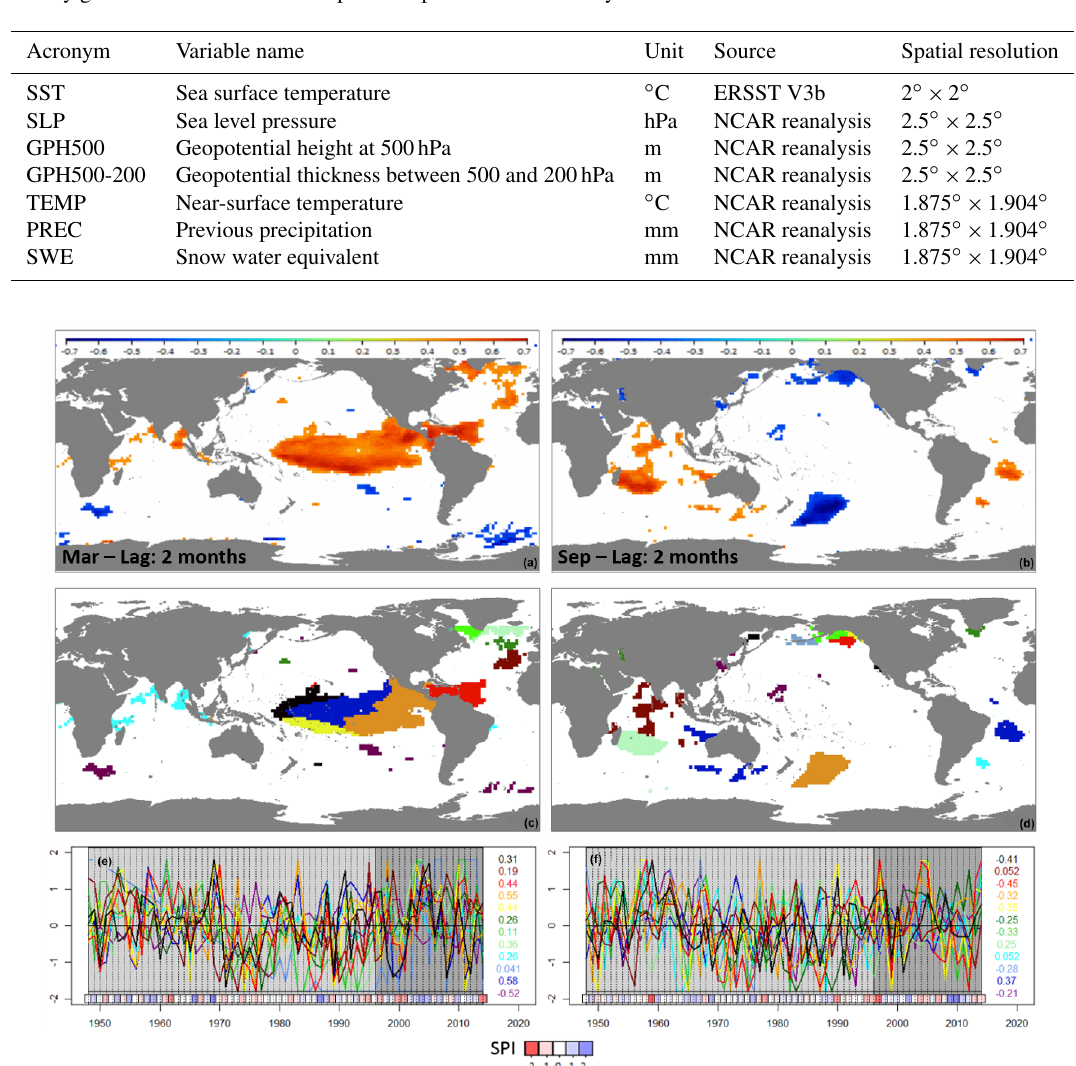
Figure 2. Correlation analysis results for precipitation anomalies of northern central Asia for March and September with a lead time of 2 months (a) and (b) show SST grid cells which are significantly correlated. (c) and (d) show the aggregation to predictor regions based on the hill-climbing k -means cluster analysis. The diagrams ( e and f ) show the time series of z normalized mean SSTs during the selected months for each of the cluster regions (same color) and the subsequent hydroclimatic variations in northern central Asia (expressed as red to blue rectangles indicting SPI values between − 2 and 2). The colored values on the right indicate the correlation of mean cluster SST anomalies and the corresponding SPI